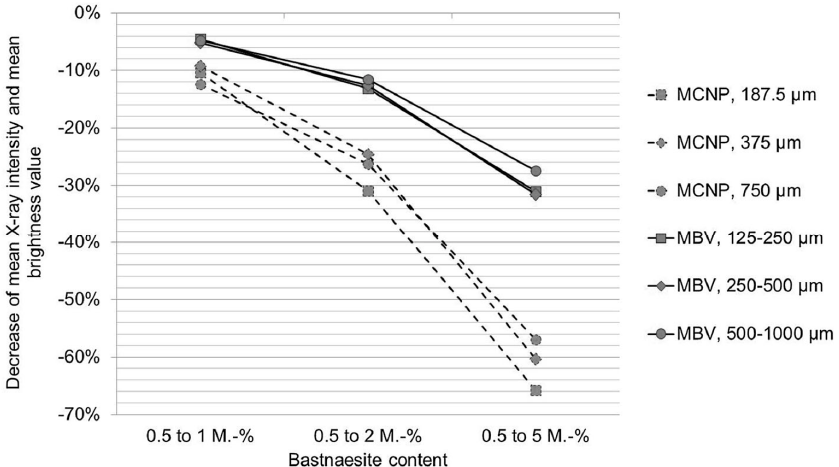
Figure 2. The relative decrease in X-ray transmission with higher bastnaesite concentrations relative to a 0.5% concentration. The results are shown for a range of bastnaesite grain sizes. The mean brightness value (MBV) and X-ray intensity are shown for the experimental tests and MCNP simulations respectively. Courtesy of Neubert and Wotruba [23].